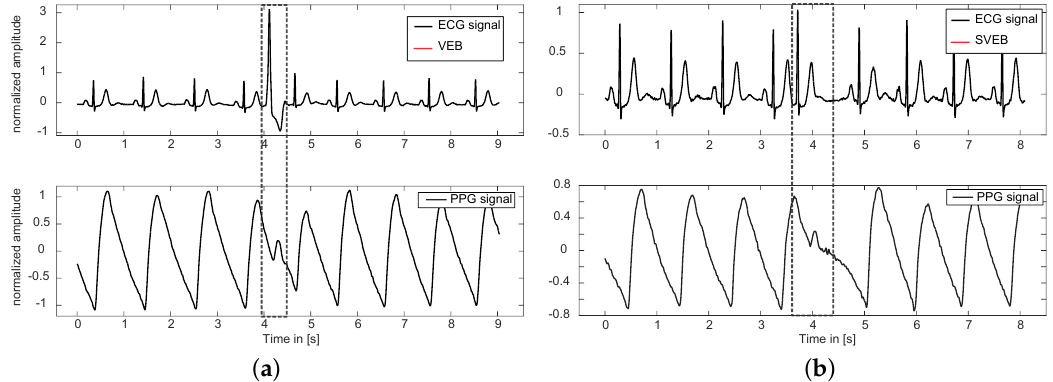
Figure 1. Synchronized electrocardiography (ECG) and photoplethysmography (PPG) waveforms. ( a ) single premature ventricular ectopic beat at t = 4 s; and ( b ) single premature supraventricular ectopic beat at t = 3.8 s. Both types of extrasystoles have a significant impact on the morphology of the arterial pulse wave, which degrades to a notch-like peak that is hard to distinguish from normal PPG dicrotic notches or slight motion artifacts. As a consequence, accurate timing considerations including pulse arrival time extraction are seriously hampered.